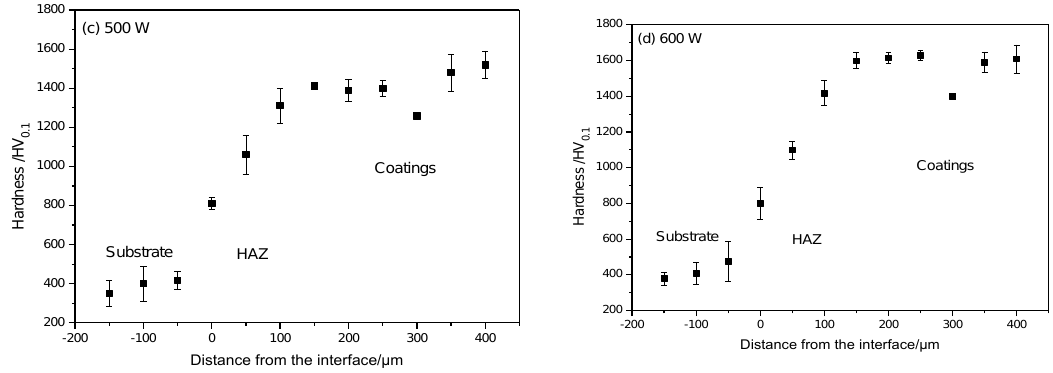
Figure 7. Micro-hardness changes through the cross-section: ( a ) as-sprayed; ( b ) 400 W; ( c ) 500 W; and ( d ) 600 W.